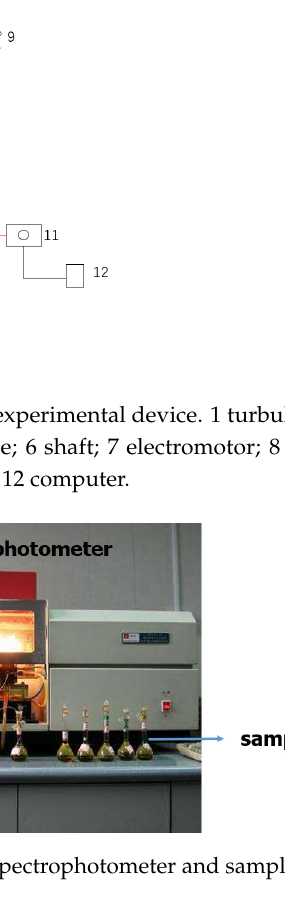
Figure 4. Schematic diagram of spectrophotometer and samples.